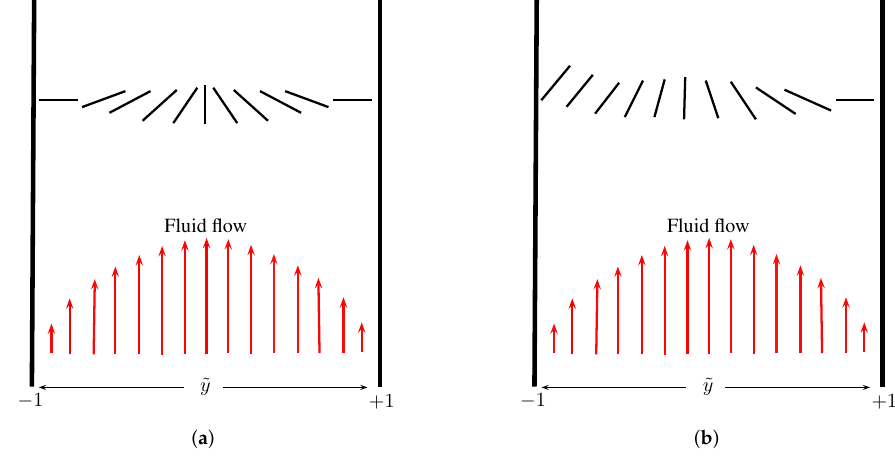
Figure 1. Schematic of the director orientation in equilibrium when applying ( a ) symmetric anchoring conditions Equation (15) and ( b ) asymmetric anchoring conditions Equation